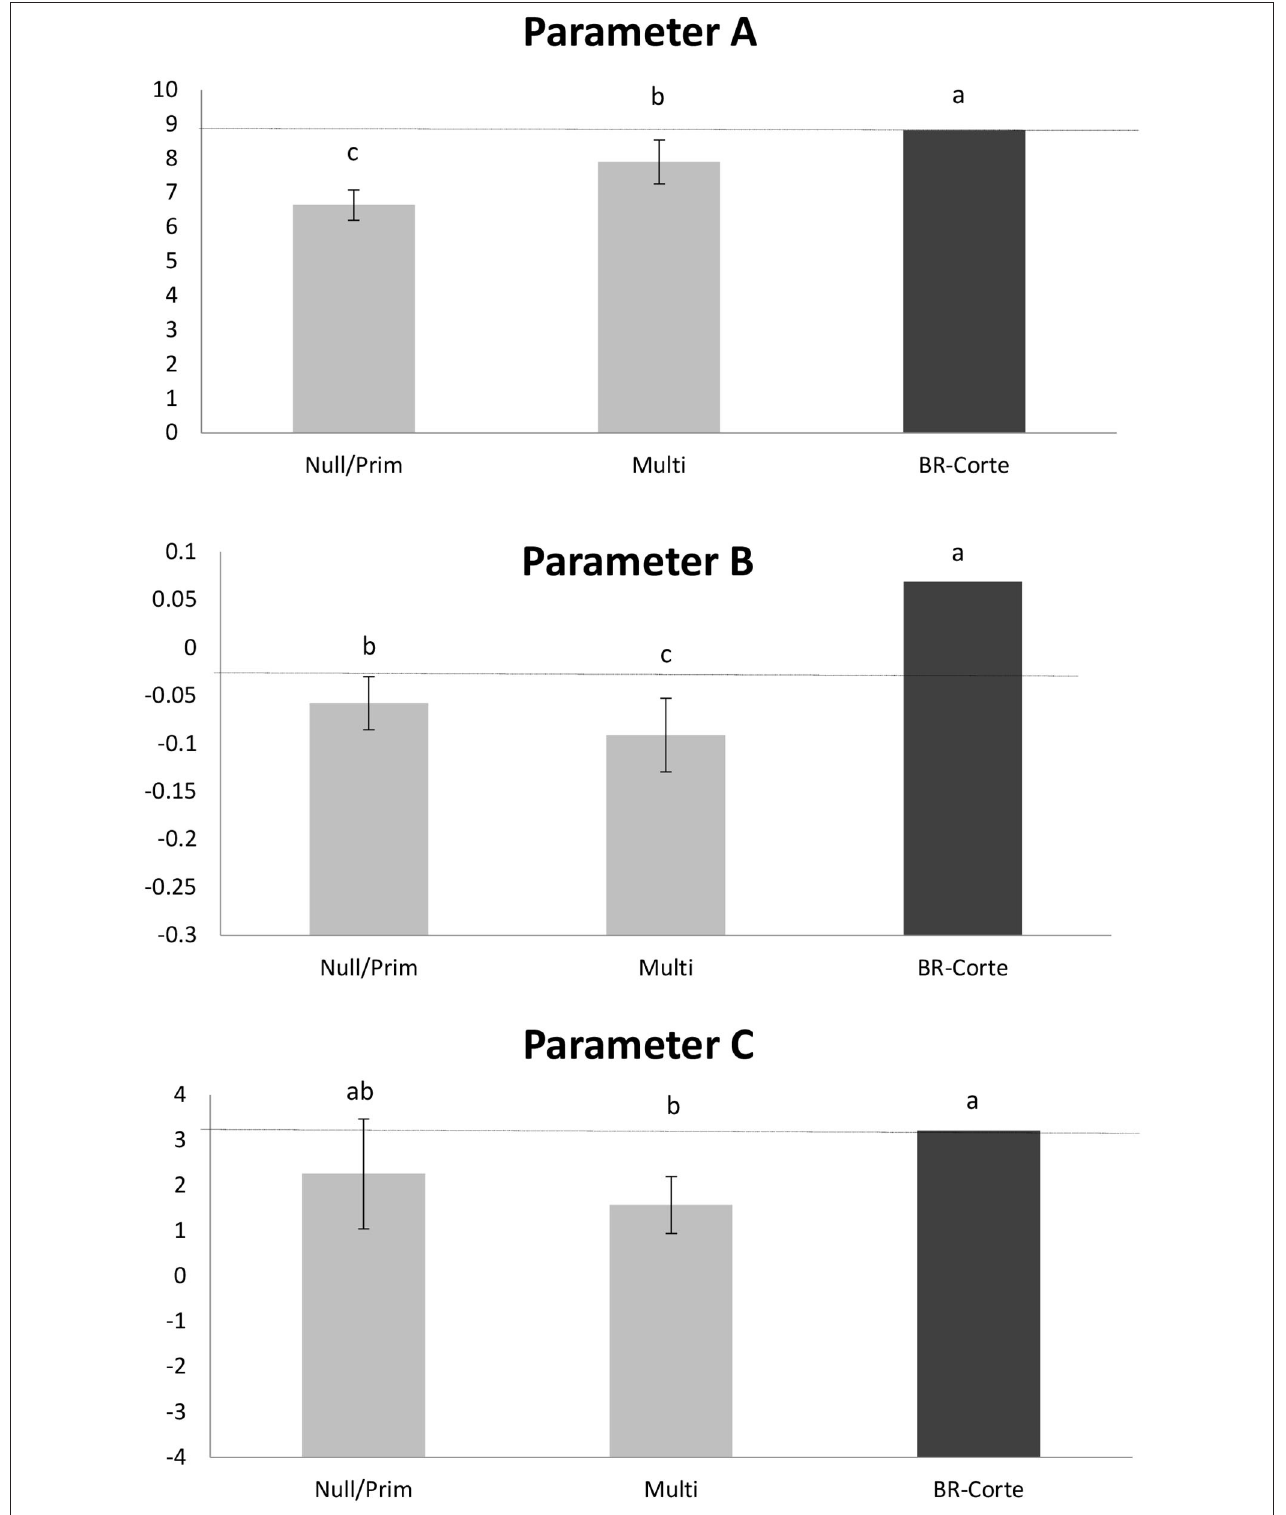
FIGURE 6 | Identity model analysis using a confidence interval approach to compare the parameters ( Y t = a + bt – e − ct ) of the three equations based on the CL model: Multi, Null/Prim, and BR-Corte. Different letters represent significant differences between parameter values.